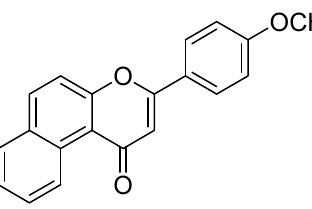
Figure 15. 3-(4-methoxyphenyl)-1 H -benzo[f]chromen-1-one